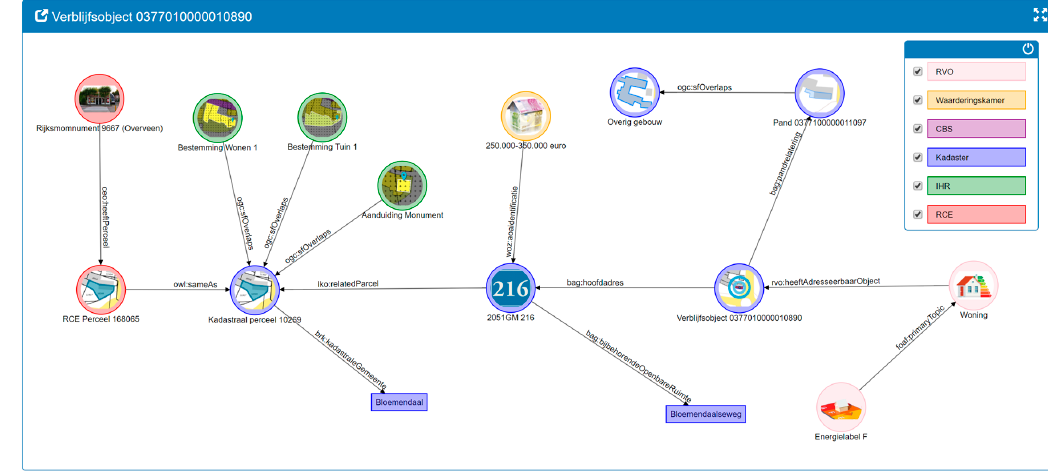
Figure 5. Visualization of a part of the KKG using the Linked Data Theater software. Colors represent organizations curating the data (source: authors).